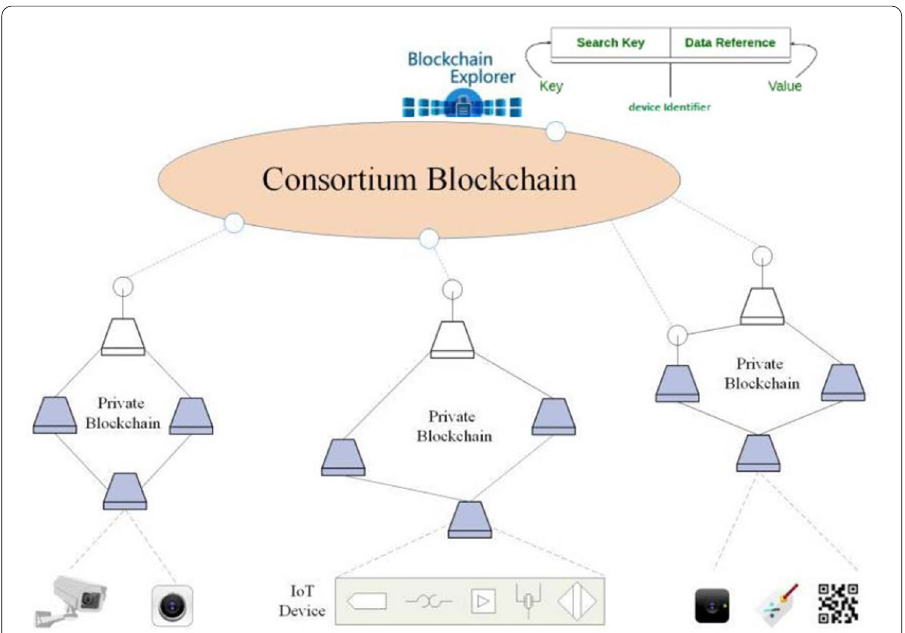
Fig. 4 Hybrid Blockchain Architecture; Illustration of the Hybrid Blockchain